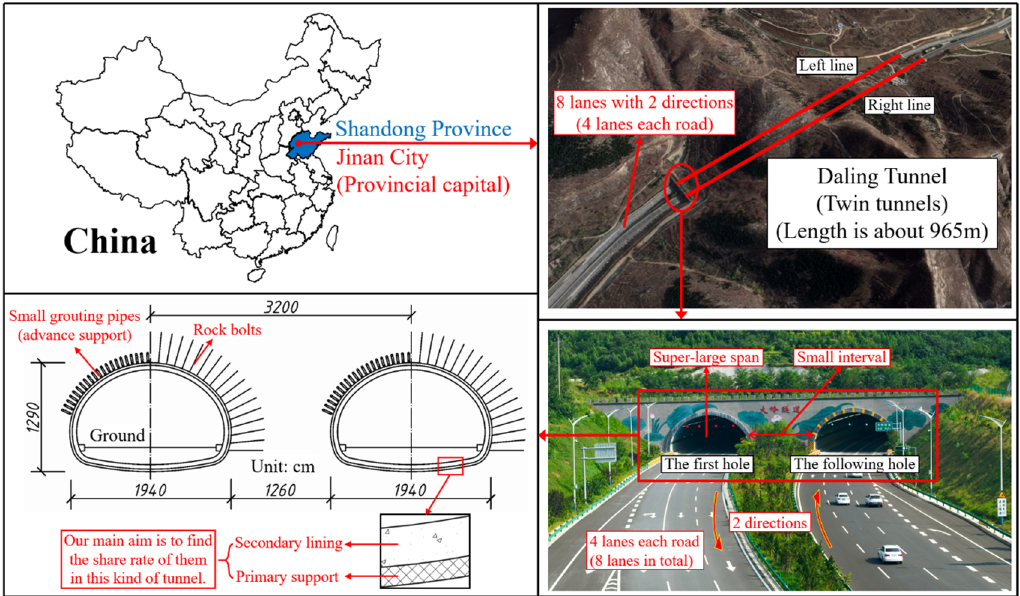
Figure 2. Information of Daling Tunnel. For optimal traffic capacity, these twin tunnels have super- large span and small interval. The main body of them are both composite lining and bolts.